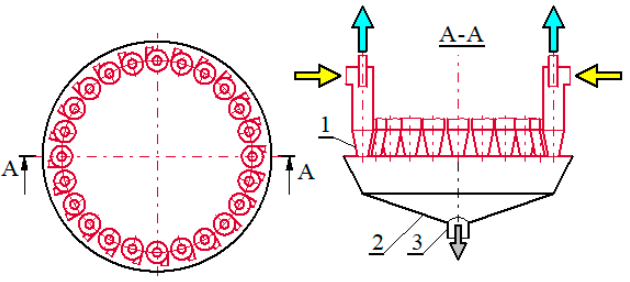
Figure 28. The diagram of dust collector with symmetrical position of all cyclones in relation to the suction stub-pipe: 1—cyclone, 2—dust collector, 3—sub-pipe of suction duct.